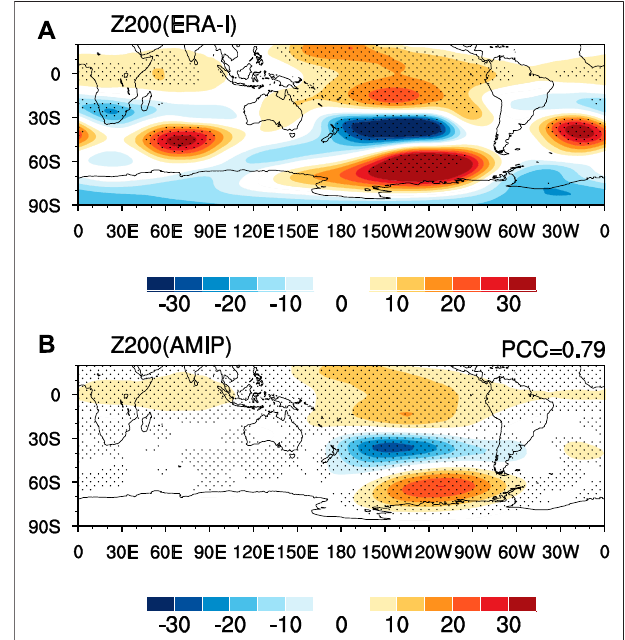
FIGURE 1 | Regression of the 200-hPa geopotential height (m) during austral winter on the Niño3.4 index in (A) ERA-I and (B) AMIP. Stippling in (A , B) suggests passing the 95% con fi dence level, and more than 70% of models agree on the sign of the multi-model ensemble (MME),